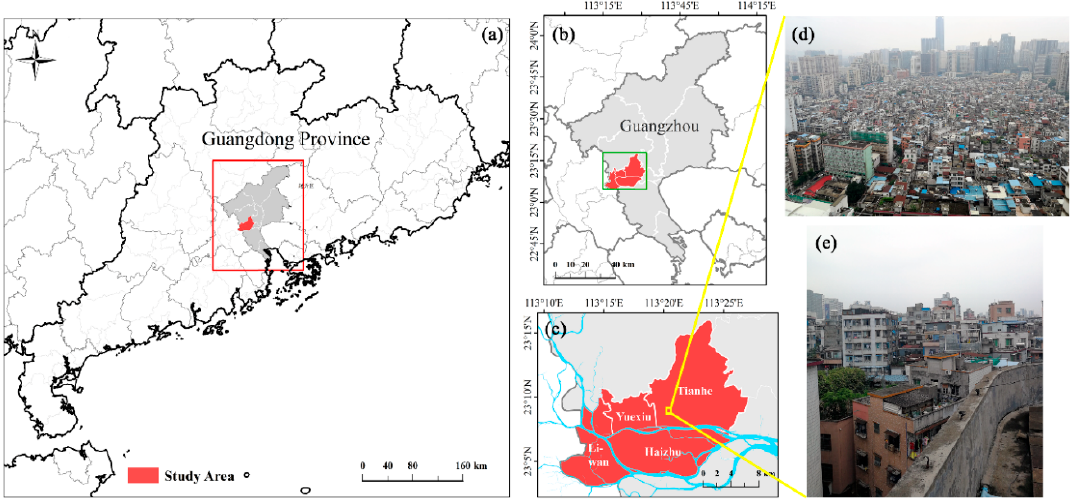
Figure 1. Location of study area. ( a , b ) The overview; ( c ) core area of Guangzhou; ( d , e ) Shipai village in the Tianhe district, Guangzhou (source: author).